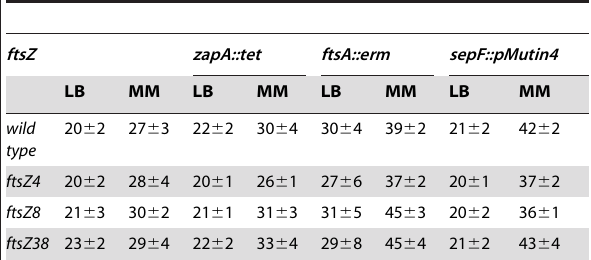
Table 1. Growth rates.